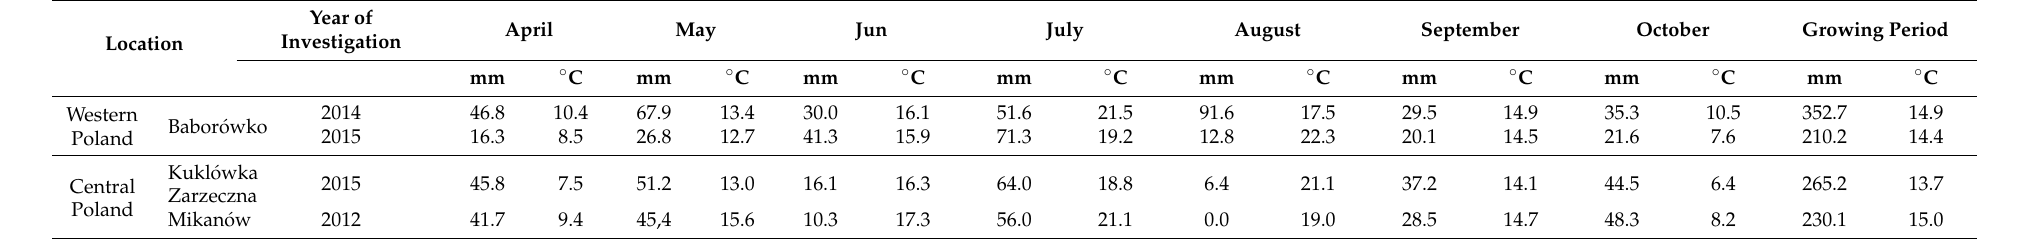
Table 1. Cumulative precipitation (mm) and average monthly air temperature ( ◦ C) during 2012, 2014, and 2015 growing seasons at the Grab ó w and Babor ó wko Experimental Stations and at the Kukl ó wka Zarzeczna farm field experiment and the Mikan ó w Scots pine